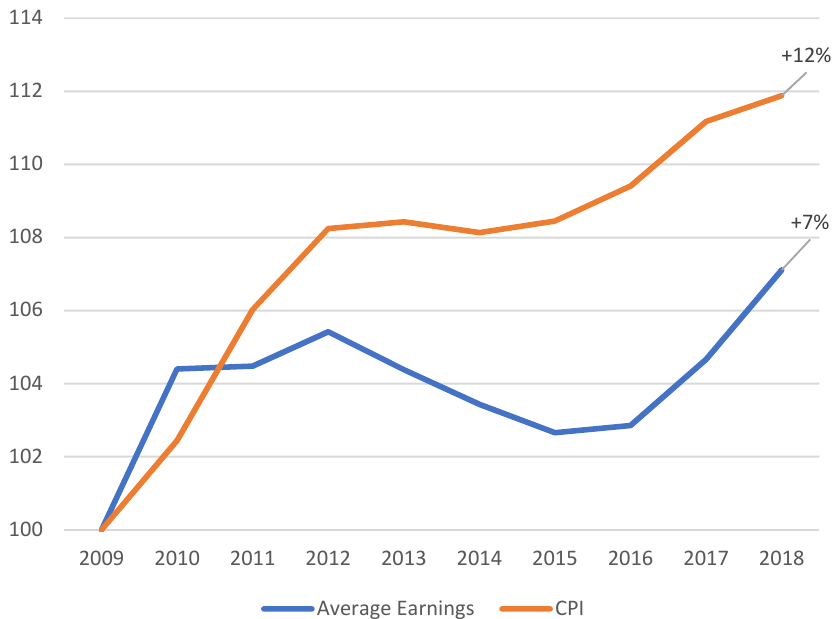
Figure 5. Average earnings per employee in Lisbon and Consumer Price Index (CPI). Base = 100 (2009). For CPI, we used the 12-month average as of 31 December. Source: PORDATA, INE.